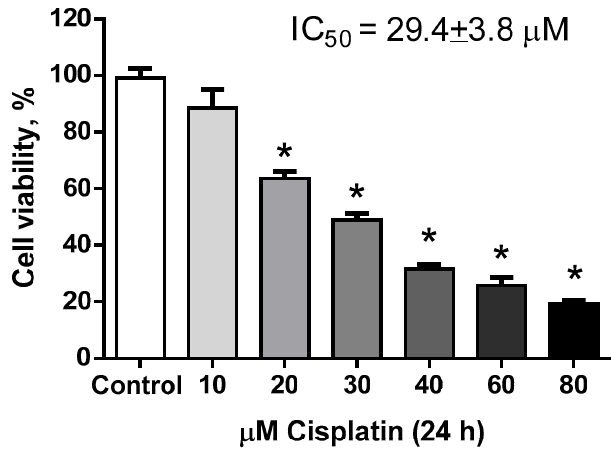
Figure 2. Cisplatin half-maximal (50%) inhibitory concentration (IC 50 ) in 24 h treated Lilly Laboratories Cell-Porcine Kidney 1 (LLC-PK1) cells. Data are mean ± standard error of the mean (SEM), n = 3. * p < 0.05 vs. control (without cisplatin).